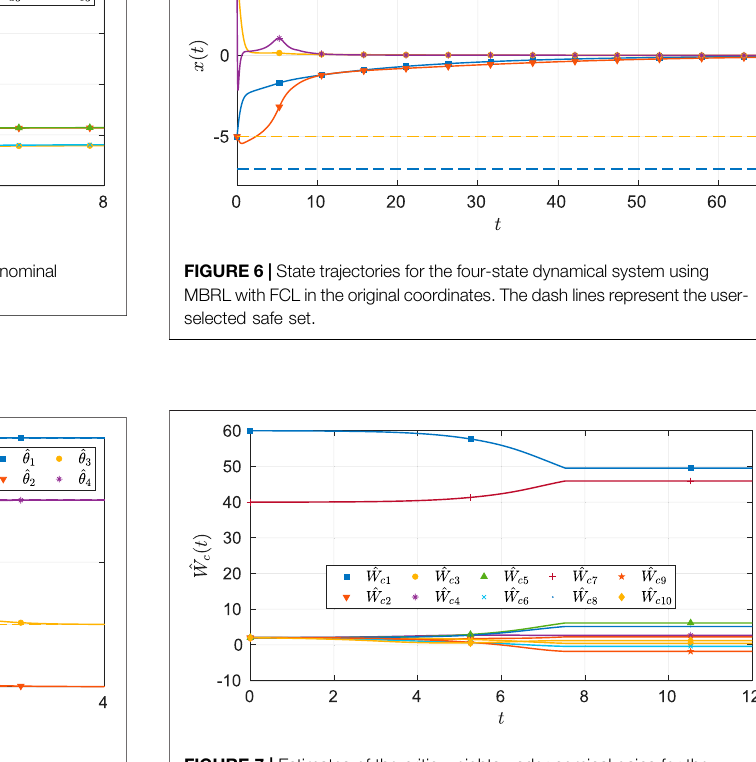
FIGURE 4 | Estimates of the unknown parameters in the system under the nominal gains for the two-state dynamical system. The dash lines in the fi gure indicates the ideal values of the parameters.